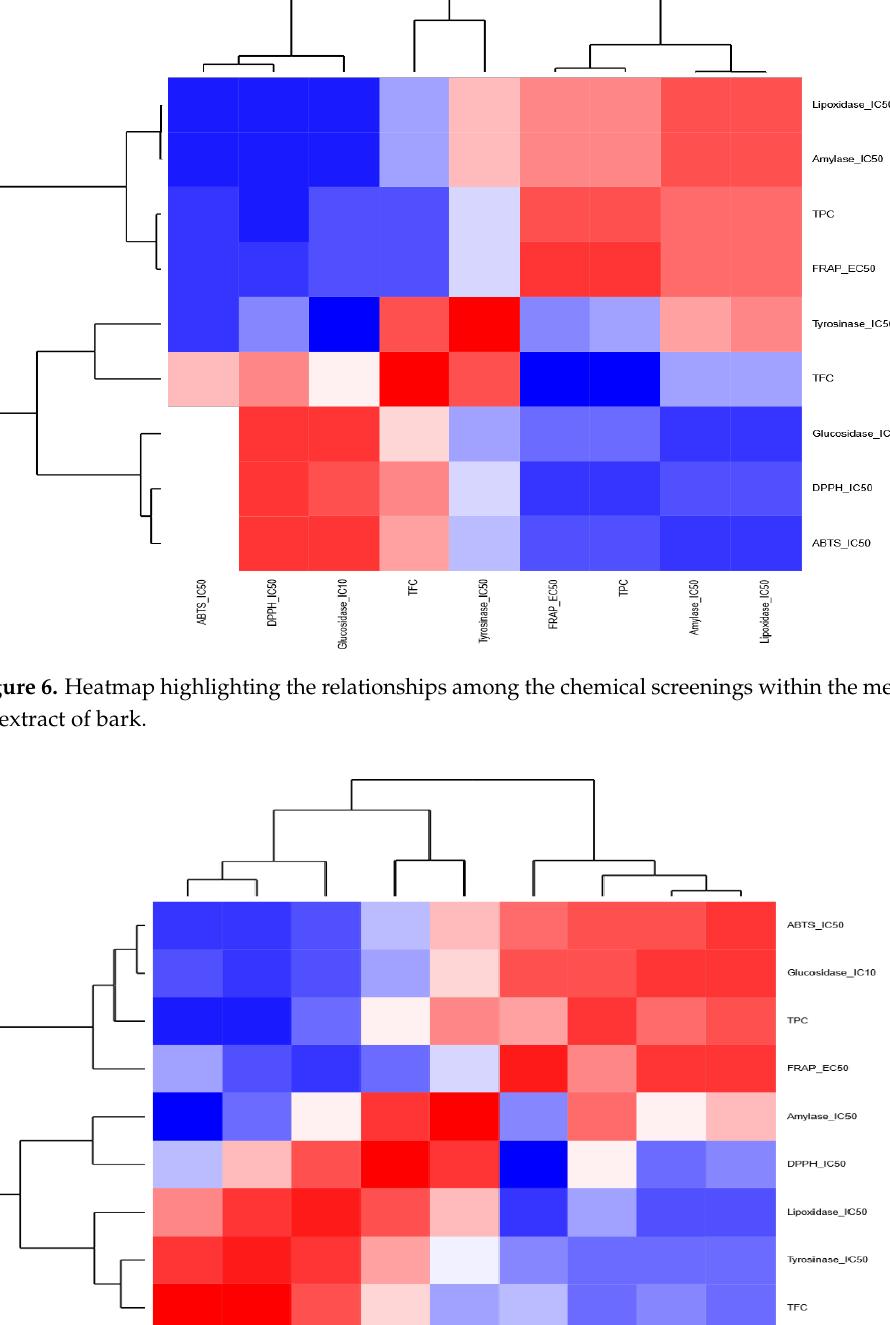
Figure 7. Heatmap highlighting the relationships among the chemical screenings within the methanolic extract of kernels.